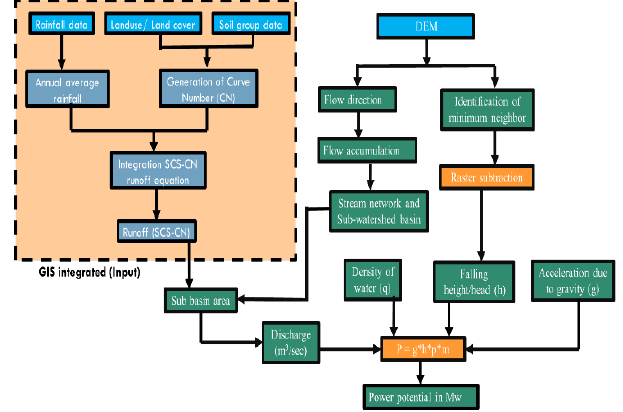
Figure 2. Workflow of the hydro potential model.